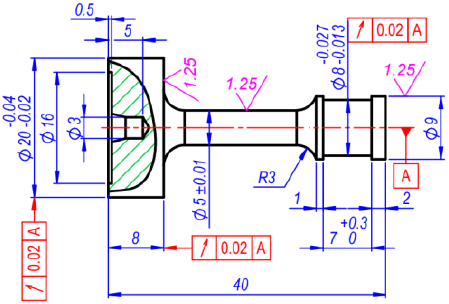
Figure 3. S pecimens for single uniaxial tension experiments (units in mm).